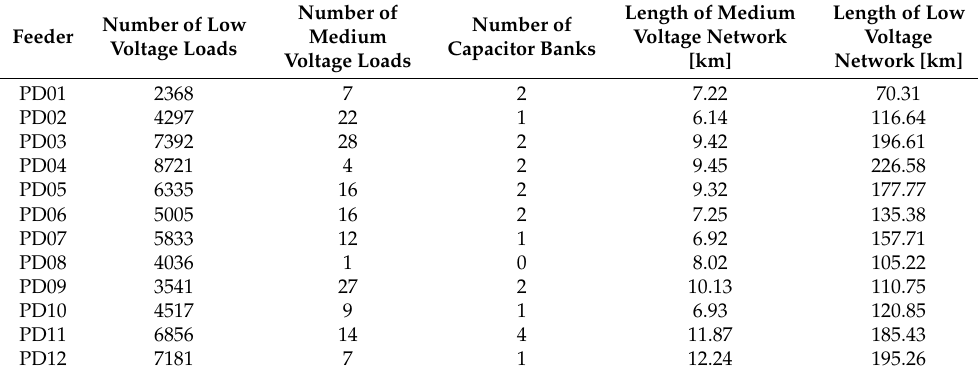
Table 3. Substation Pedreira’s feeders typical